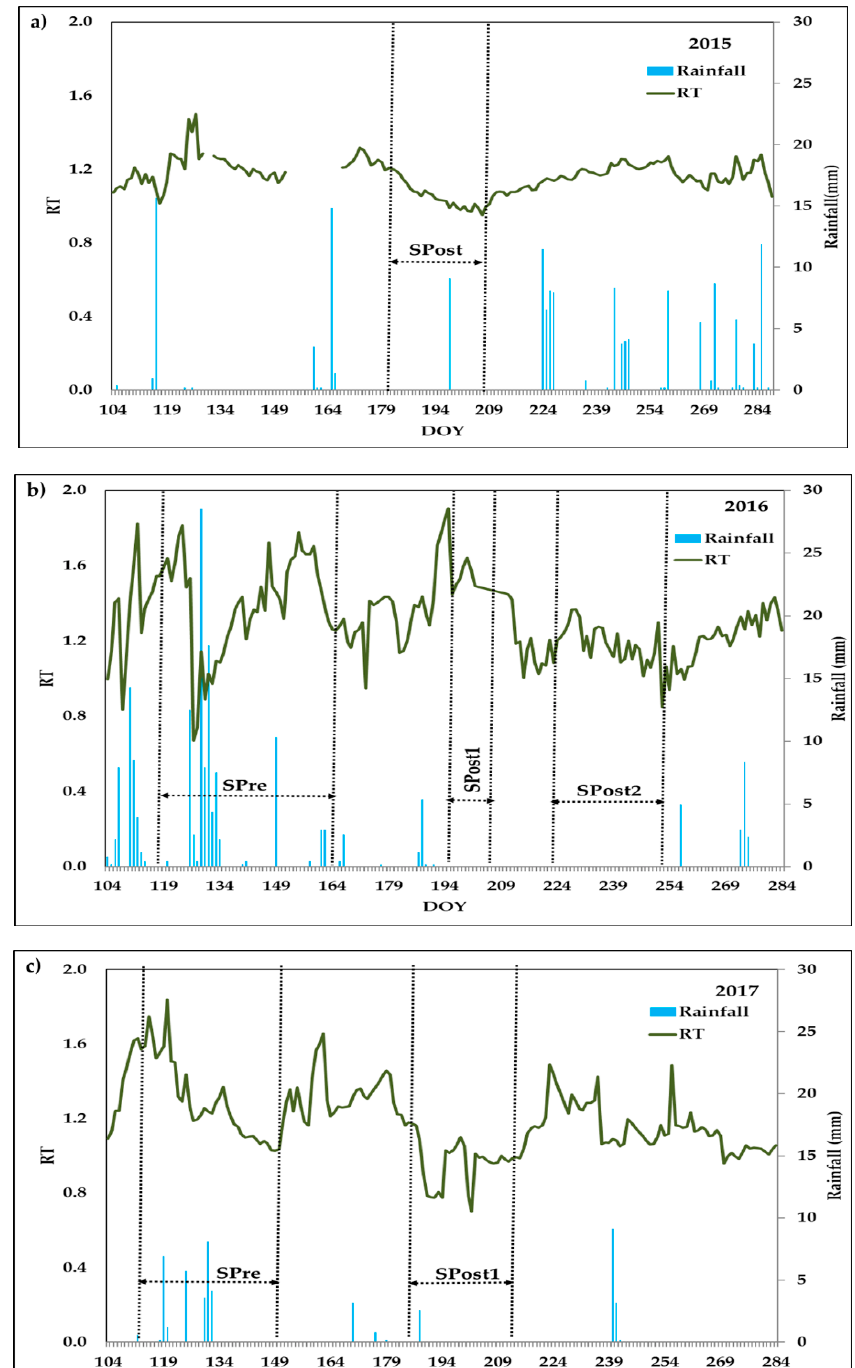
Figure 4. Evolution of relative transpiration (RT) for the 3 years of the study: ( a ) 2015, ( b ) 2016 and ( c ) 2017. Values correspond to the average of four trees. The vertical black dashed line marks the start and end of the drying period. DOY is day of the year.